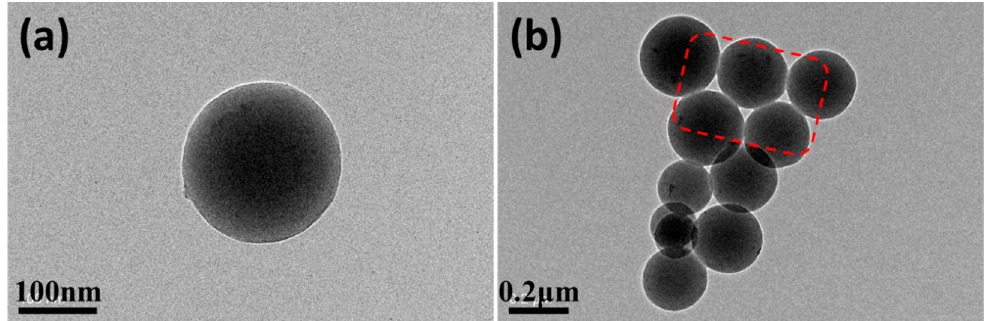
Figure 11. TEM images of DEaTIPS samples with the evaporation temperature at 30 °C: ( a ) a well separated nanoparticle, ( b ) a very small amount of agglomeration.